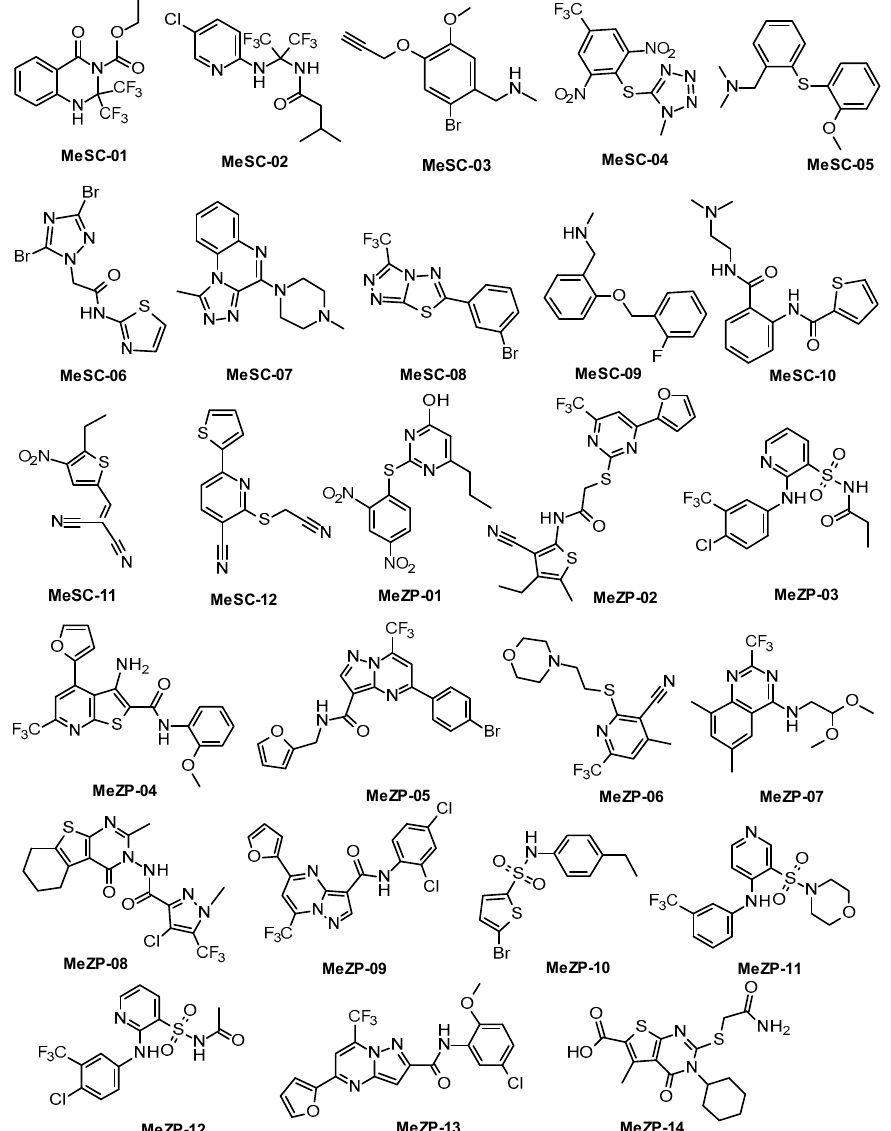
Figure 2. Chemical structures of compounds resulting from the VS employing SC-D (compounds MeSC-01–MeSC-12) and ZPD-2 (compounds MeZP-01–MeZP-22) as query